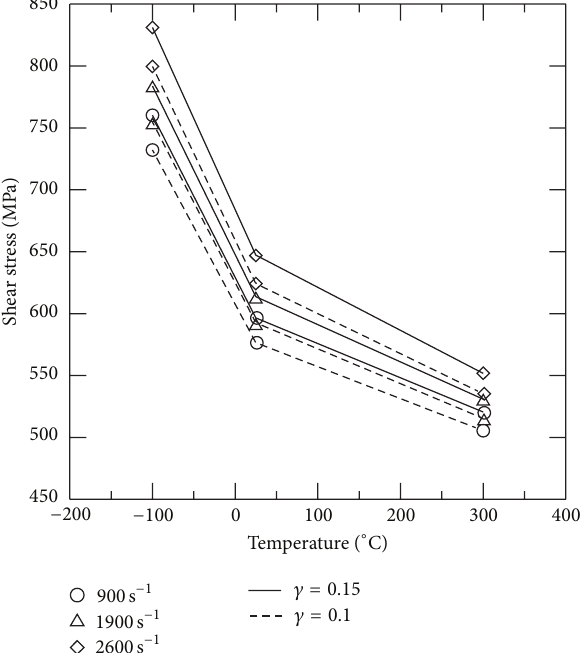
Figure 4: Variation of shear stress with temperature as a function of strain rate and strain.